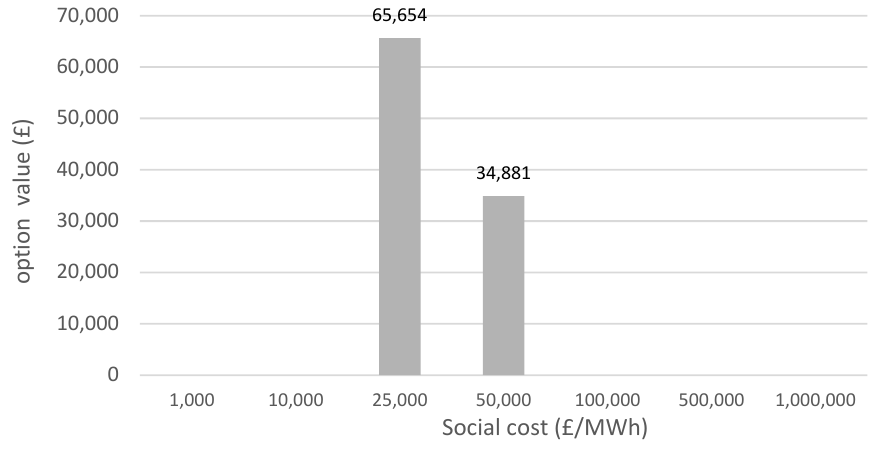
Figure 12. Option Value of Smart Charging as a function of social cost, using BIF.